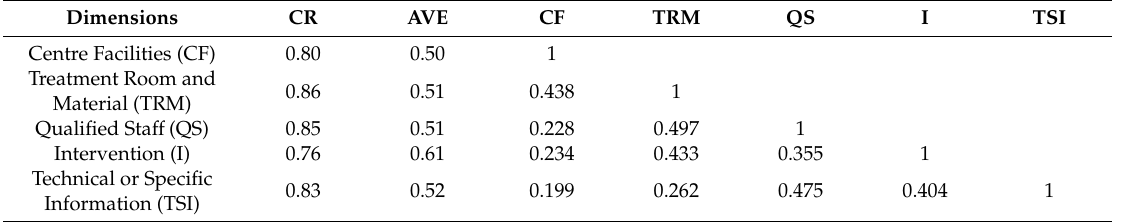
Table 4. Composite reliability, average variance extracted and discriminant